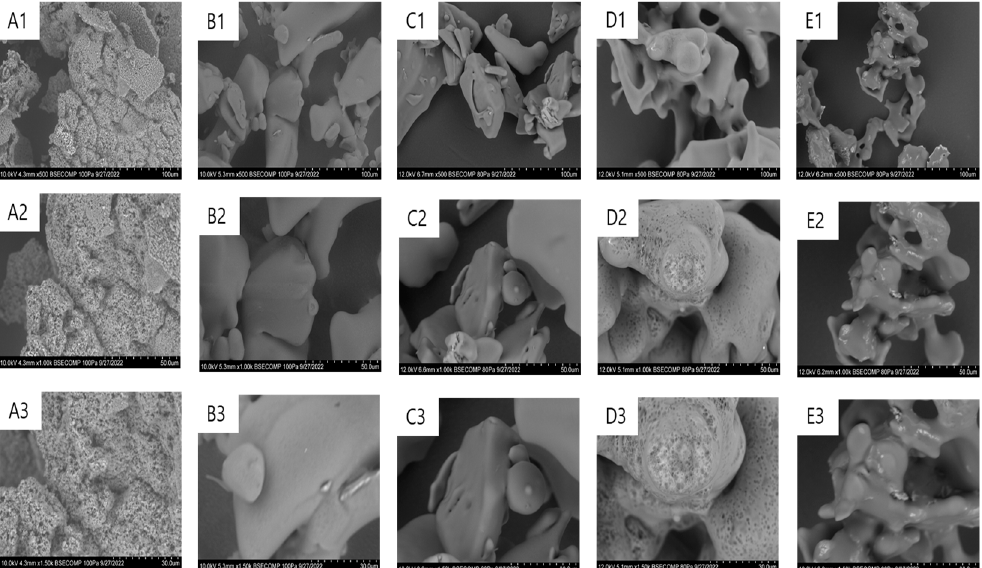
Figure 2. The morphology of vegetal diamine oxidase (vDAO) lyophilized samples: ( A ) vDAO, ( B ) with sucrose—vDAO-SUC, ( C ) with trehalose—vDAO-TRE, ( D ) Sucrose (SUC) alone, and ( E ) Trehalose (TRE) alone; SEM magnification (1) × 500, (2) × 1000, and (3) × 1500.